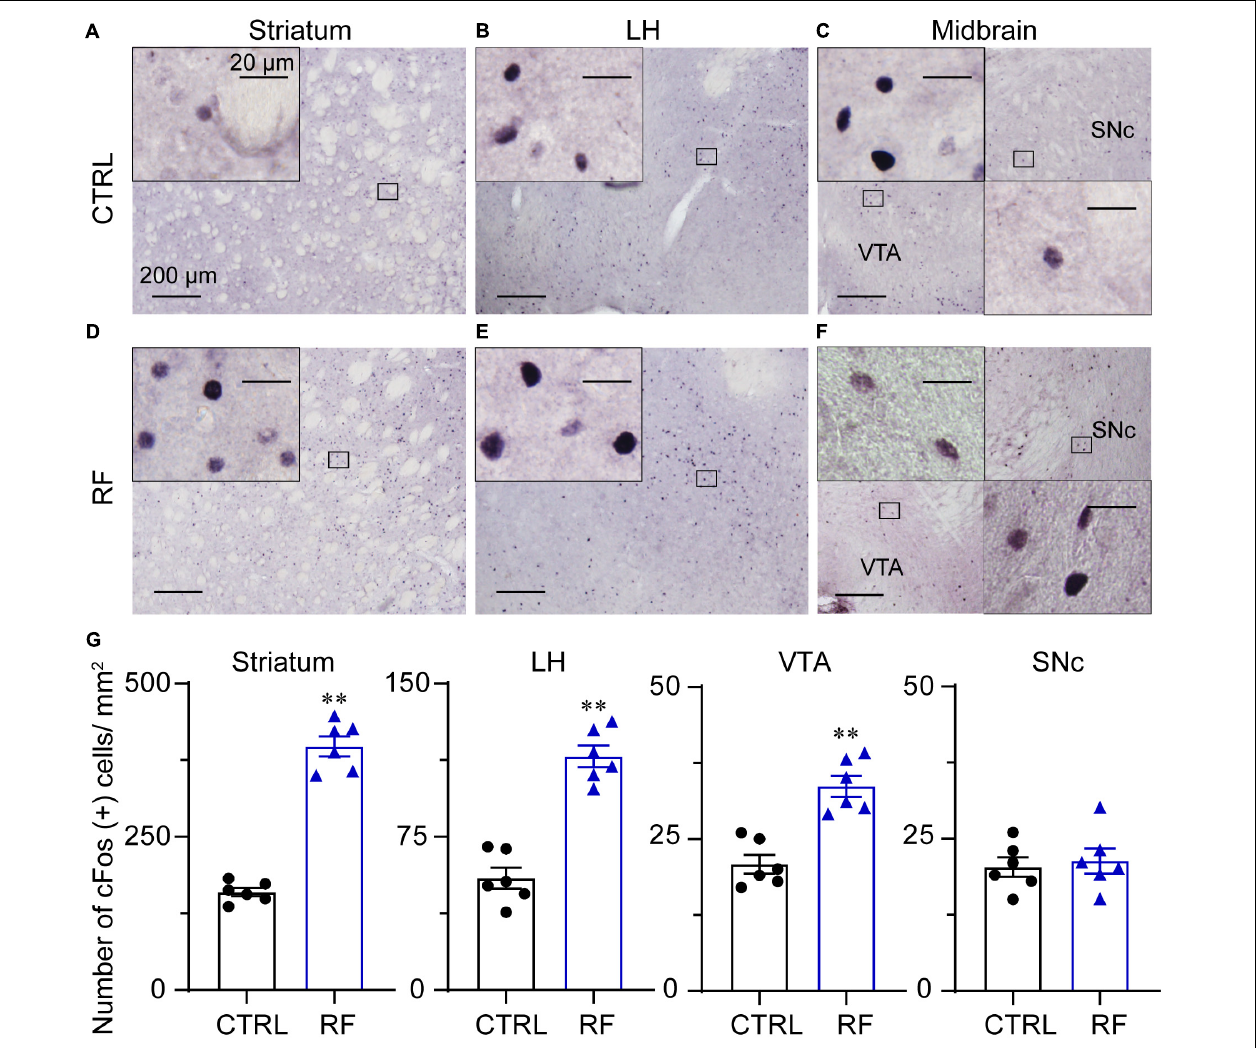
FIGURE 9 | Expression of the c-Fos protein in the RF and CTRL mice. Representative images of c-Fos expression in the striatum (A,D) , LH (B,E) , and midbrain (C,F) of the CTRL and RF mice, respectively. (G) Mean numbers of c-Fos-positive neurons in the striatum, LH, VTA, and SNc. ∗∗ p < 0.01 versus CTRL, n = 6. CTRL, control; RF, restricted feeding; LH, lateral hypothalamus; VTA, ventral tegmental area; SNc, substantia nigra pars